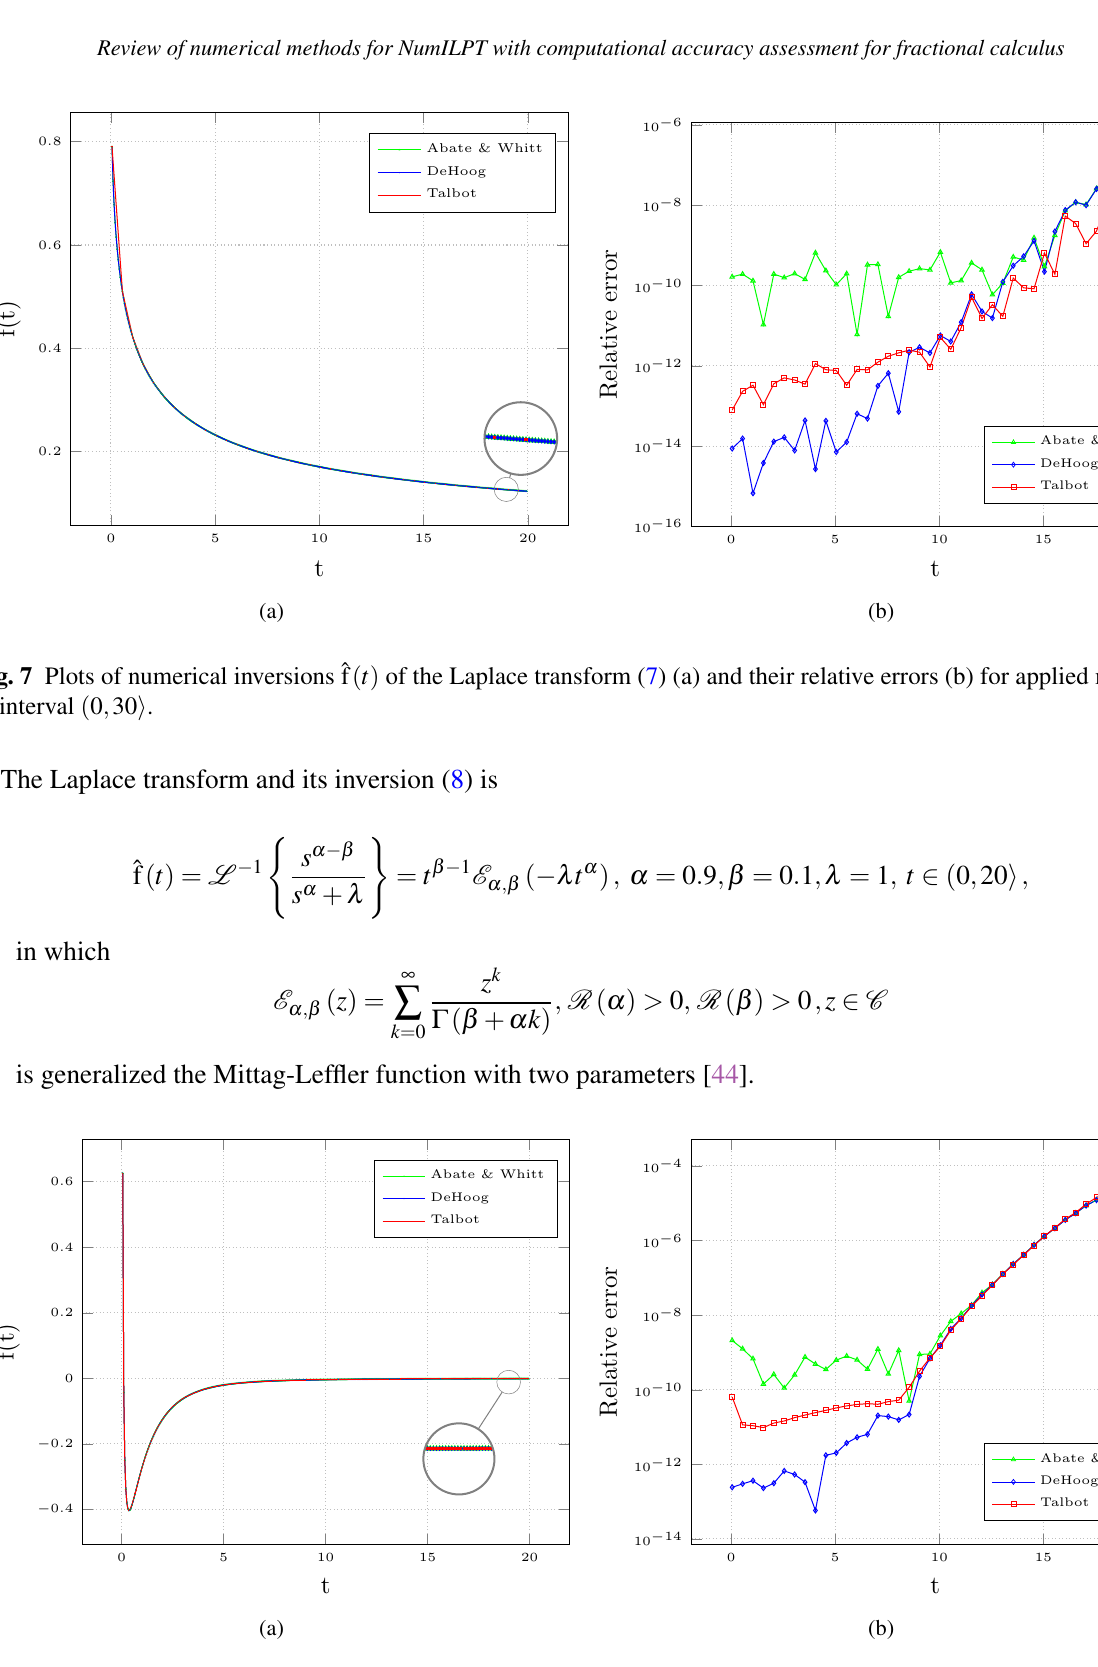
Fig. 8 Plots of numerical inversions ˆf ( t ) of the Laplace transform (8) (a) and their relative errors (b) for applied methods in interval ( 0 , 30 (cid:105)